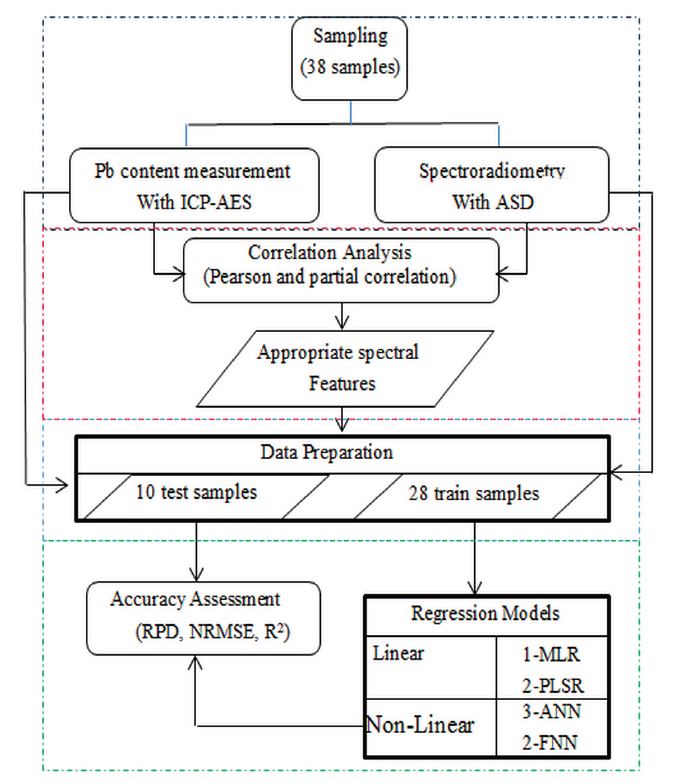
Figure 3. Flowchart of